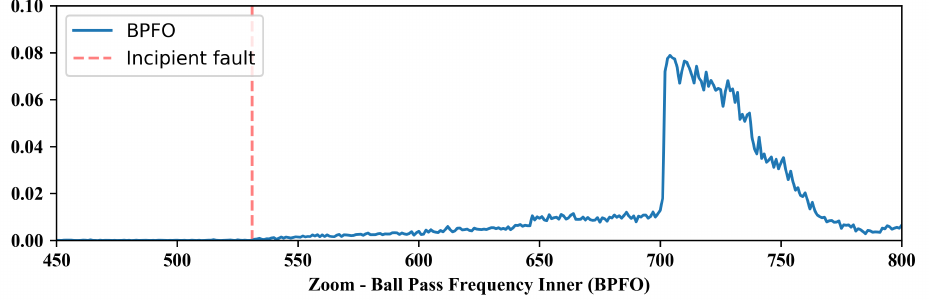
Figure 8. Zoom of BPFO